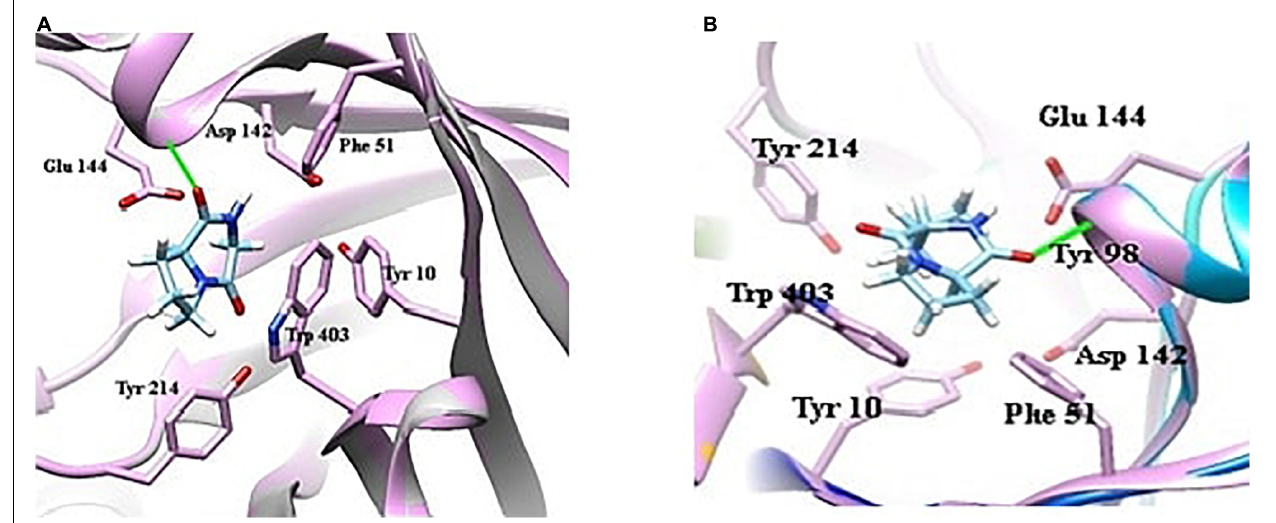
FIGURE 7 | Docking view of bacterial protein chitinase B (Serrattia marcescens) with compounds identified in B. seminalis JRBHU6. (A) Represents the docking of PPDH. (B) Represents the docking of PPDHMP.